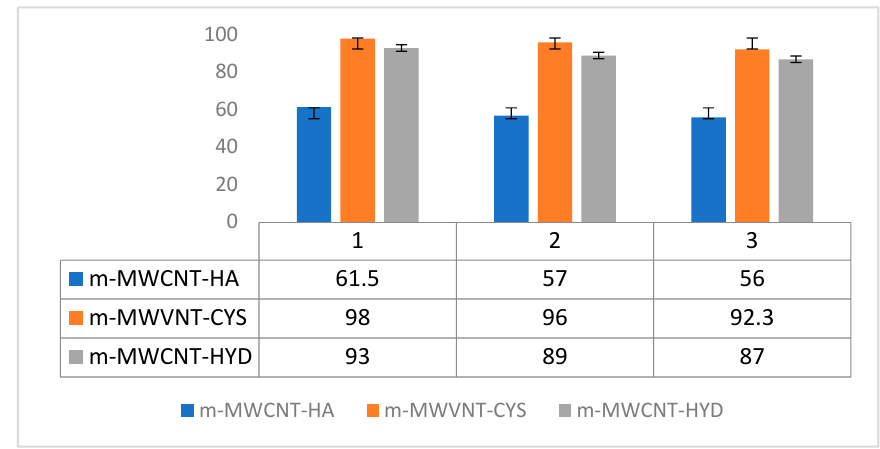
Figure 13. Three trials of adsorption–desorption of MWCNT using different functional groups towards removal efficiency of Ibu.